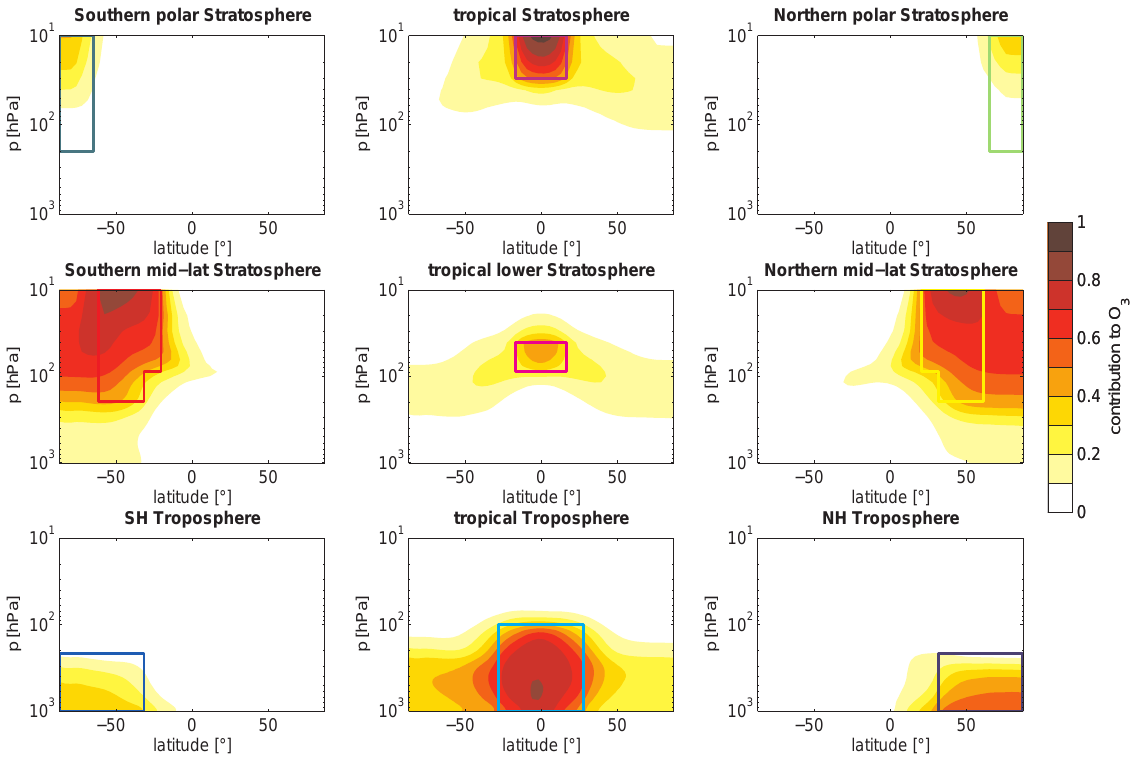
Fig. 5. Climatology (2000–2009) of the contribution of ozone originating from the regions indicated by the boxes to the full ozone field ( O i 3 /O 3 ) for each of the nine source regions.